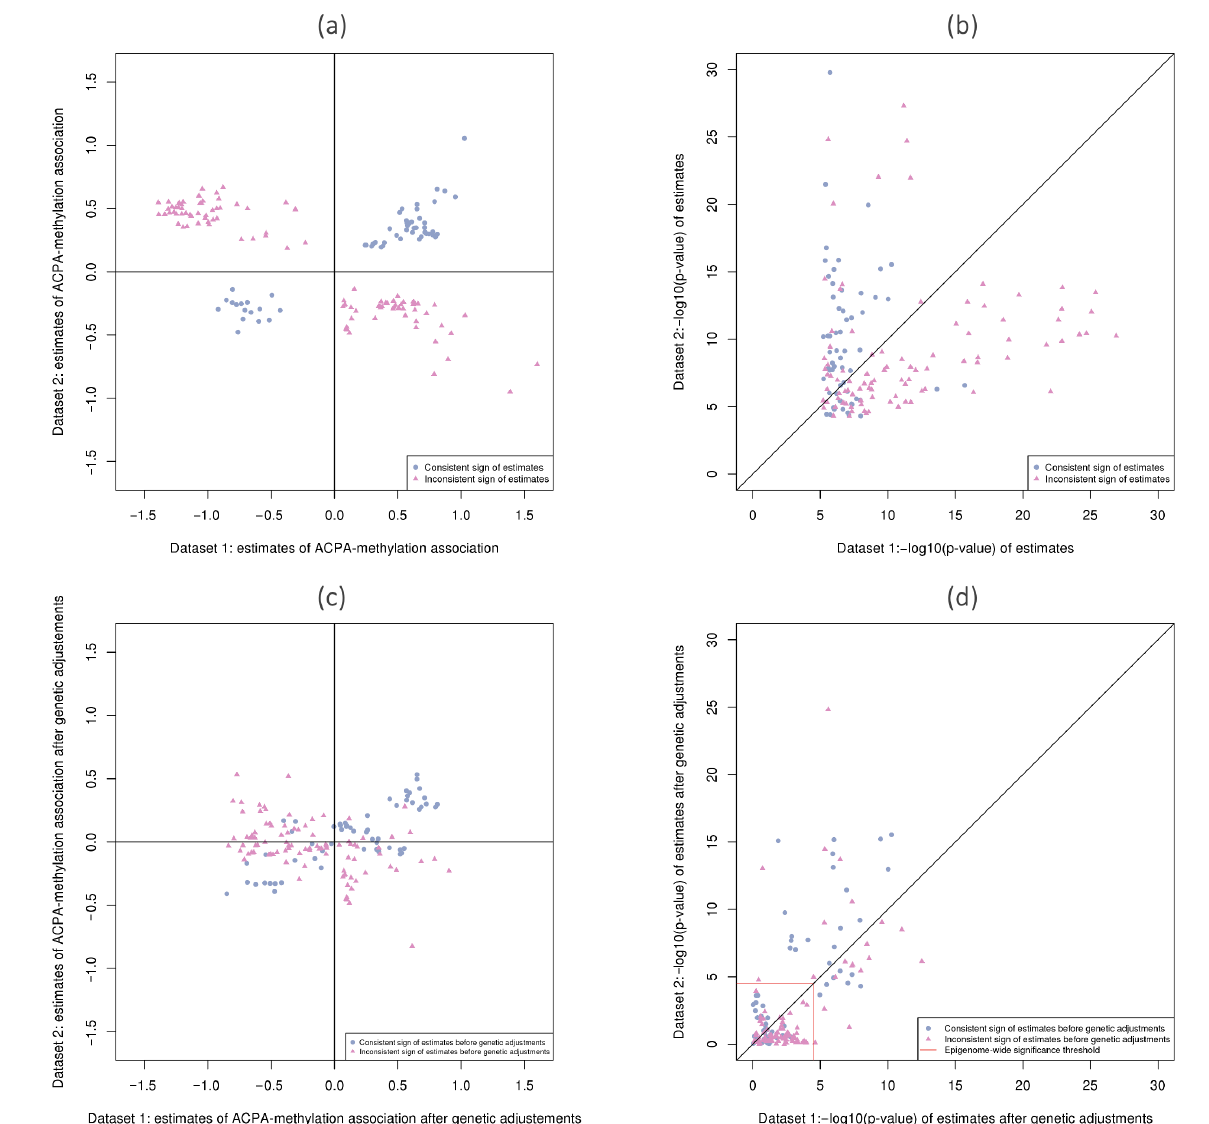
Figure 4. Scatter plots illustrating agreement between results for the 157 CpGs identified as demonstrating ACPA- methylation associations in both Dataset 1 and Dataset 2. ( a ) Estimated model coefficients (log odds ratios) from the EWAS binomial regressions. Points are colored in blue if the coefficient signs agree, and in pink otherwise; ( b ) − log10( p -values) from EWAS binomial regressions; ( c ) estimated coefficients (log odds ratios) after genetic adjustments; ( d ) − log10( p -values) after genetic adjustments including lines indicating significance threshold (3 × 10 − 5 ). Shapes and colors for points in ( b – d ) correspond to those assigned in panel ( a ) for intuitive tracking of their